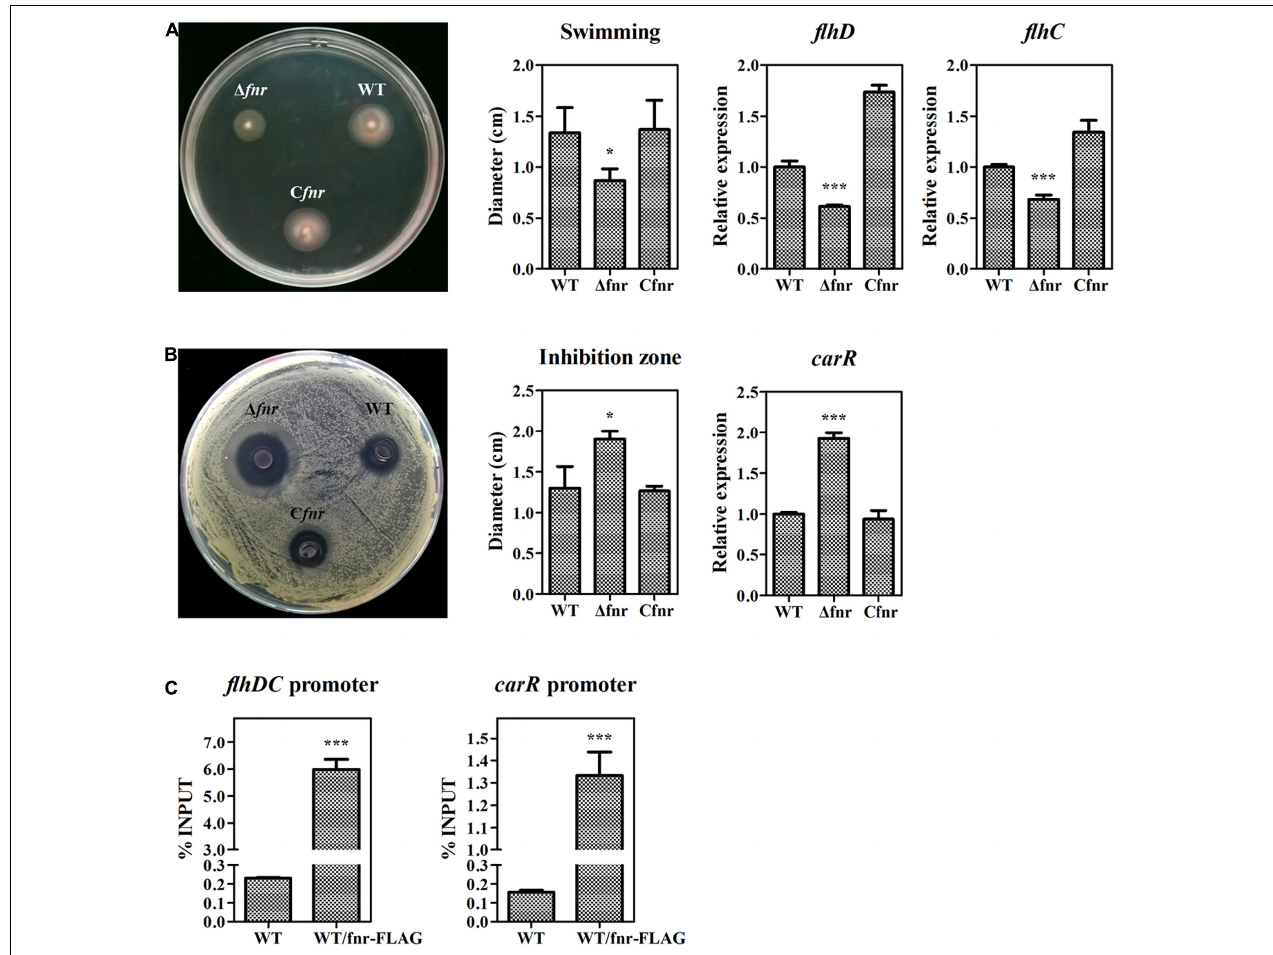
FIGURE 5 | Fnr is a global regulator in Serratia sp. ATCC 39006. (A) Swimming activity (left), the diameter (cm) of the swimming zone (middle), and the transcription level of flhD and flhC (right) in WT, (cid:49) fnr , and C fnr . (B) Bacteriostatic activity (left), the diameter (cm) of the inhibition zone (middle), and the transcription level of carR (right) in WT, (cid:49) fnr , and C fnr . (C) In vivo ChIP-qPCR analysis of Fnr-FLAG binding to the promoters of the carR gene and the flhDC operon. Anti-FLAG affinity gel was used to precipitate the protein-DNA complex, and WT was used as the negative control. The Y -axis indicates the relative enrichment value of Fnr on its target site, which was calculated by comparing the Ct value of the sample and input. The transcription level of the tested genes in WT was assigned as 1. The experiments were performed in triplicate, and the data are shown as the mean ± SD. Student’s t -test was used to analyze the statistical significance (* p < 0.05, *** p <